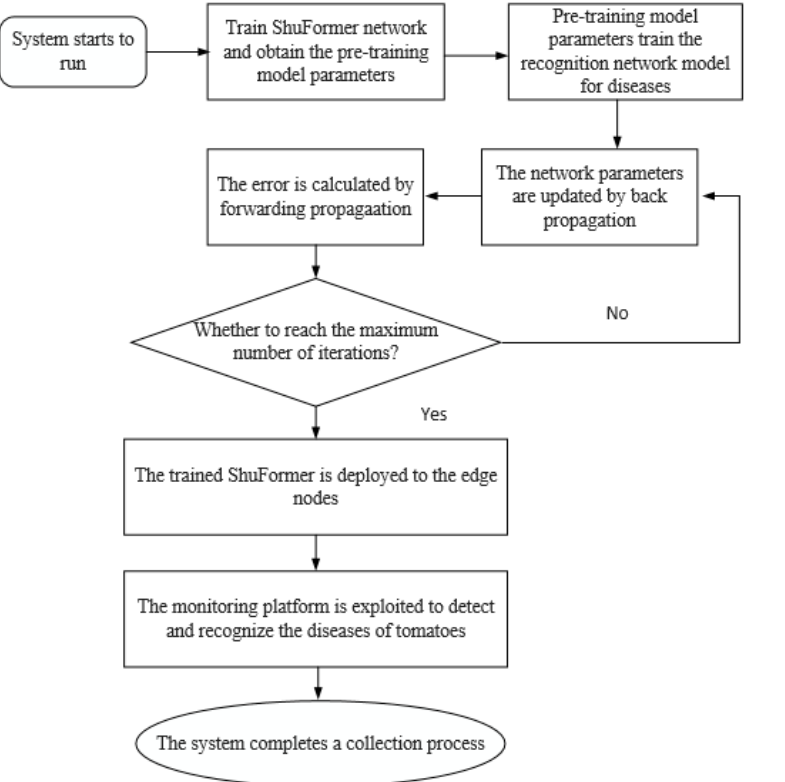
Figure 8. Tomatoes’ diseases detection system flow chart.